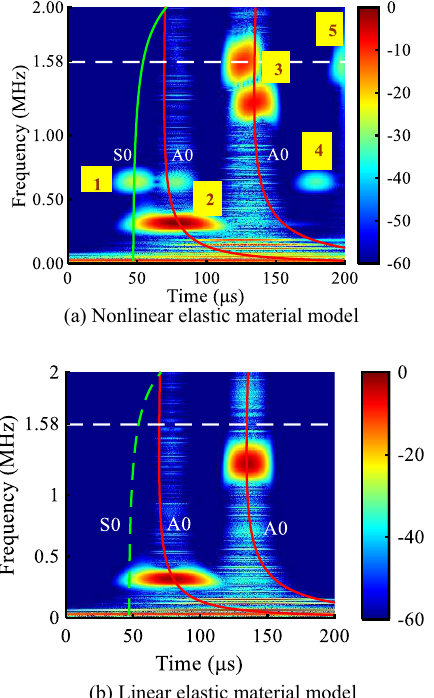
Figure 6 Time–frequency distributions of signals obtained from two